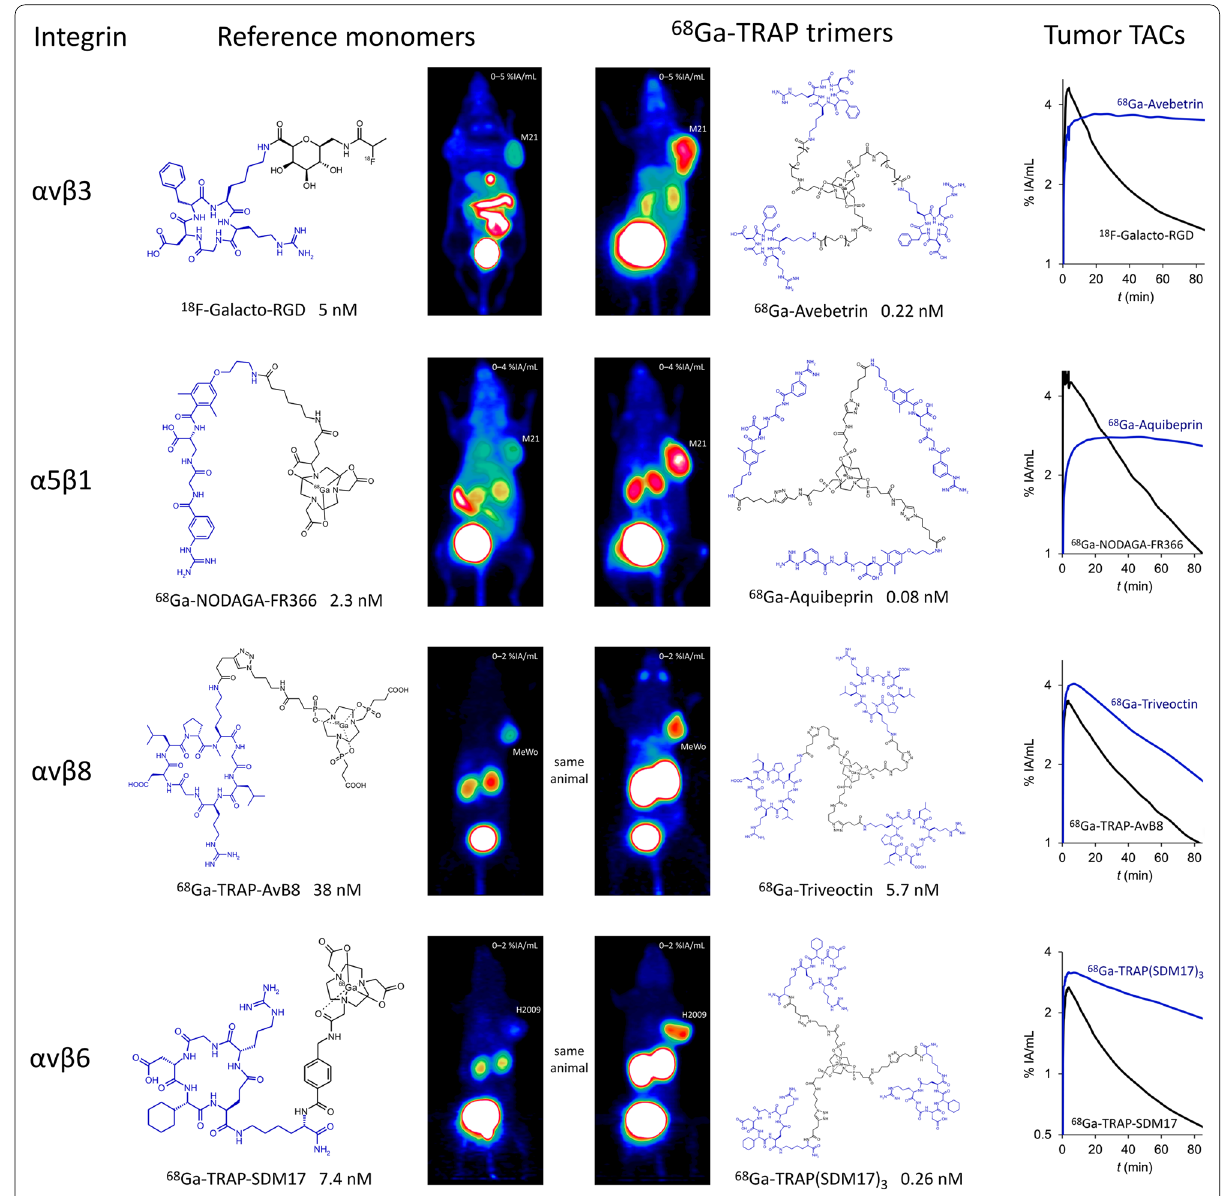
Fig. 7 Comparison of µPET images (MIPs of static scans; αvβ3, α5β1, αvβ6: 75 min p.i.; αvβ8: 60 min p.i.) in SCID mice bearing subcutaneous xenografts of integrin-expressing tumor cell lines (M21: αvβ3 and α5β1; MeWo: αvβ8; H2009: αvβ6) for the radiolabeled monomers 18 F-Galacto-RGD [83], 68 Ga-NODAGA-FR366 [102], 68 Ga-TRAP-AvB8 [34], and 68 Ga-TRAP-SDM17 [32], with their corresponding TRAP trimers 68 Ga-Avebetrin [27, 83], 68 Ga-Aquibeprin [27], 68 Ga-Triveoctin [104], and 68 Ga-TRAP(SDM17) 3 [105], respectively. Structures of comprised integrin ligands (see Fig. 2) are highlighted in blue. IC 50 values (given in nM) are denoted for the respective targeted integrins (see left column). Time-activity curves in the right column were derived from ROI-based analysis of 90-min dynamic µPET scans (the high initial uptakes for 18 F-Galacto-RGD and 68 Ga-NODAGA-FR366 are signal crosstalk artifacts resulting from non-optimal tumor position close to the main